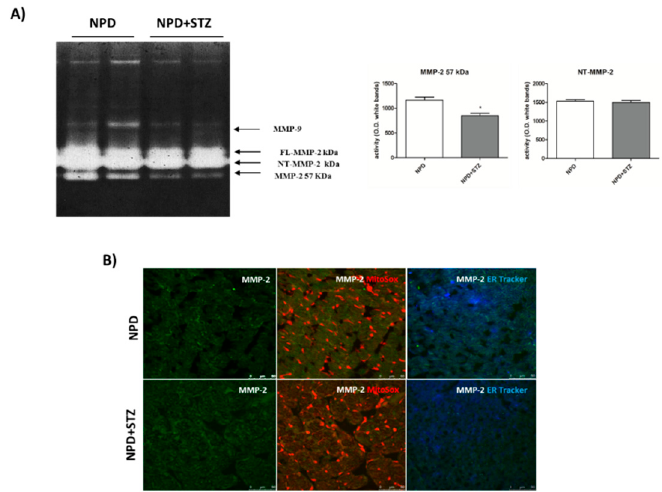
Figure 6. Effect of hyperglycaemia on MMP ‐ 2 activity and localization in myocardial tissue. ( A ) Zymogram showed a decreased activation of the extracellular MMP ‐ 2 (57 kDa) in NPD + STZ rats compared with the NPD group, whereas no difference of full ‐ length FL ‐ MMP ‐ 2 and N ‐ terminal truncated isoform of MMP ‐ 2 (NT ‐ MMP ‐ 2) activities was detected. ( B ) Representative images of